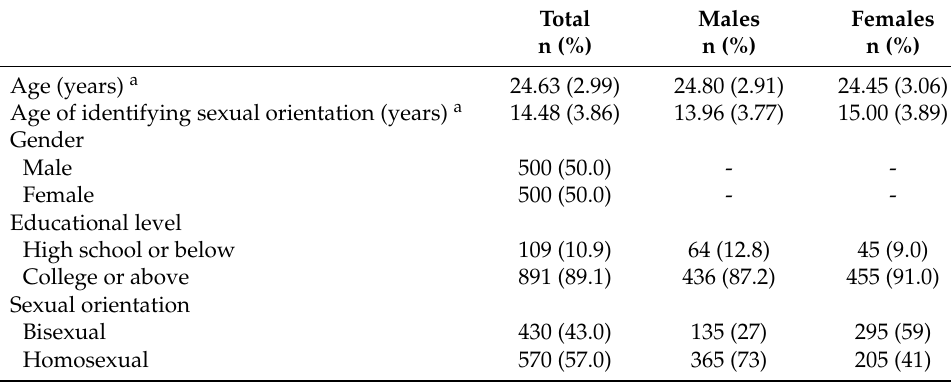
Table 1. Participants’ characteristics ( N =